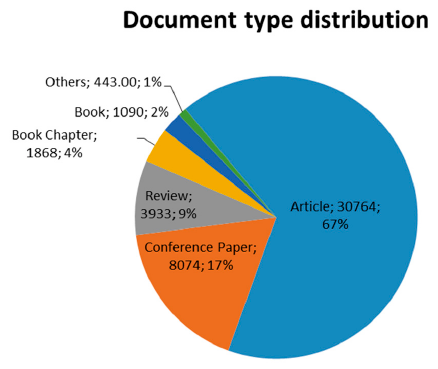
Figure 1. Chart representation of document type distribution during period 1977–2017.